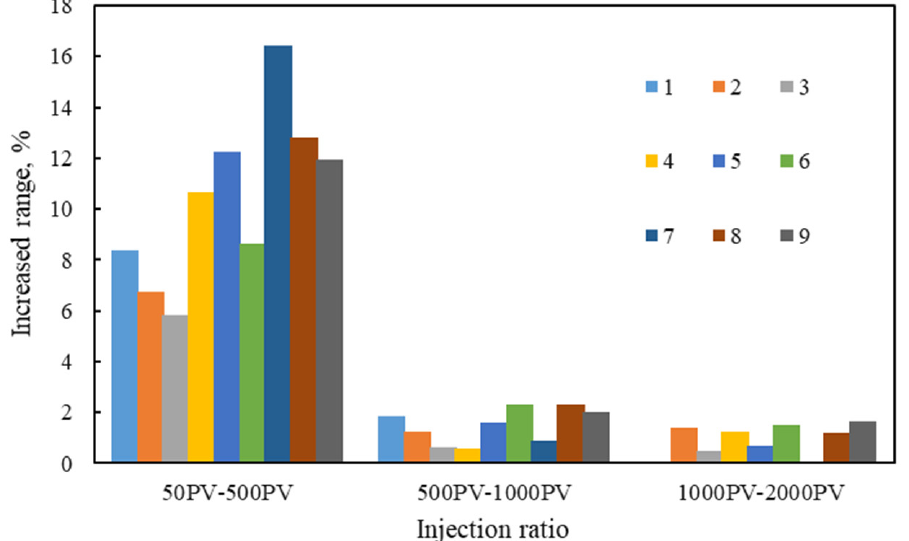
Figure 5. The range of oil displacement efficiency improvement in different water waterflooding PVs.